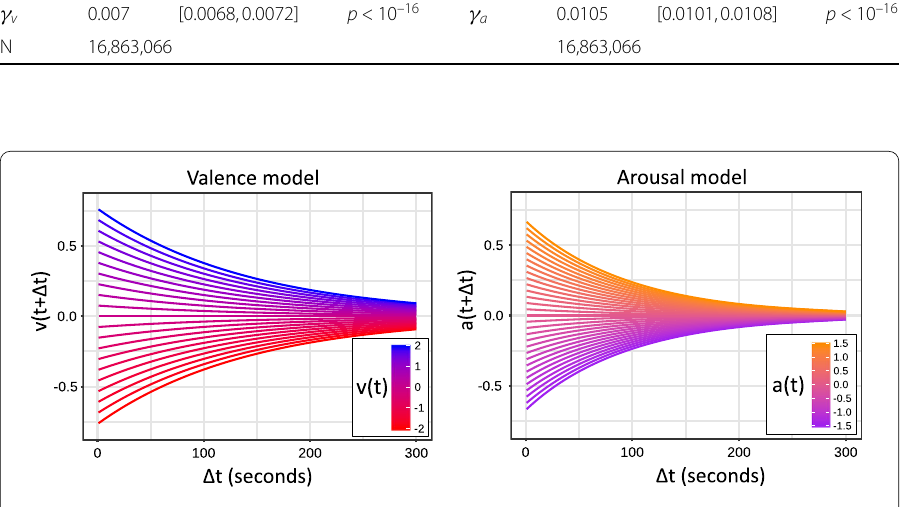
Figure 5 Emotion dynamic profiles in the fitted models. Estimated next value of valence and arousal after (cid:4) t seconds in both fitted models. Arousal relaxes faster than valence